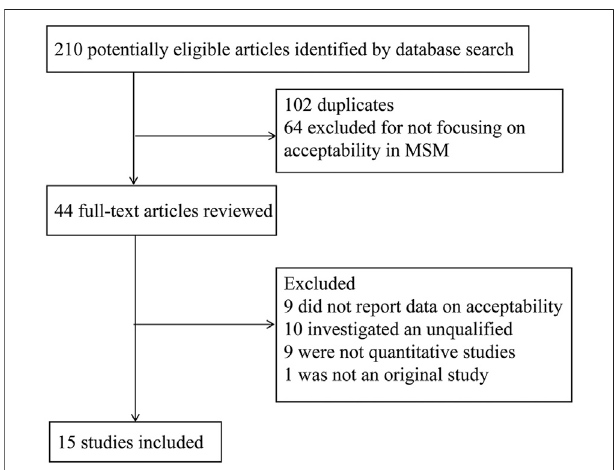
FIGURE 1 | Flow diagram of the article selection. MSM, men who have sex with